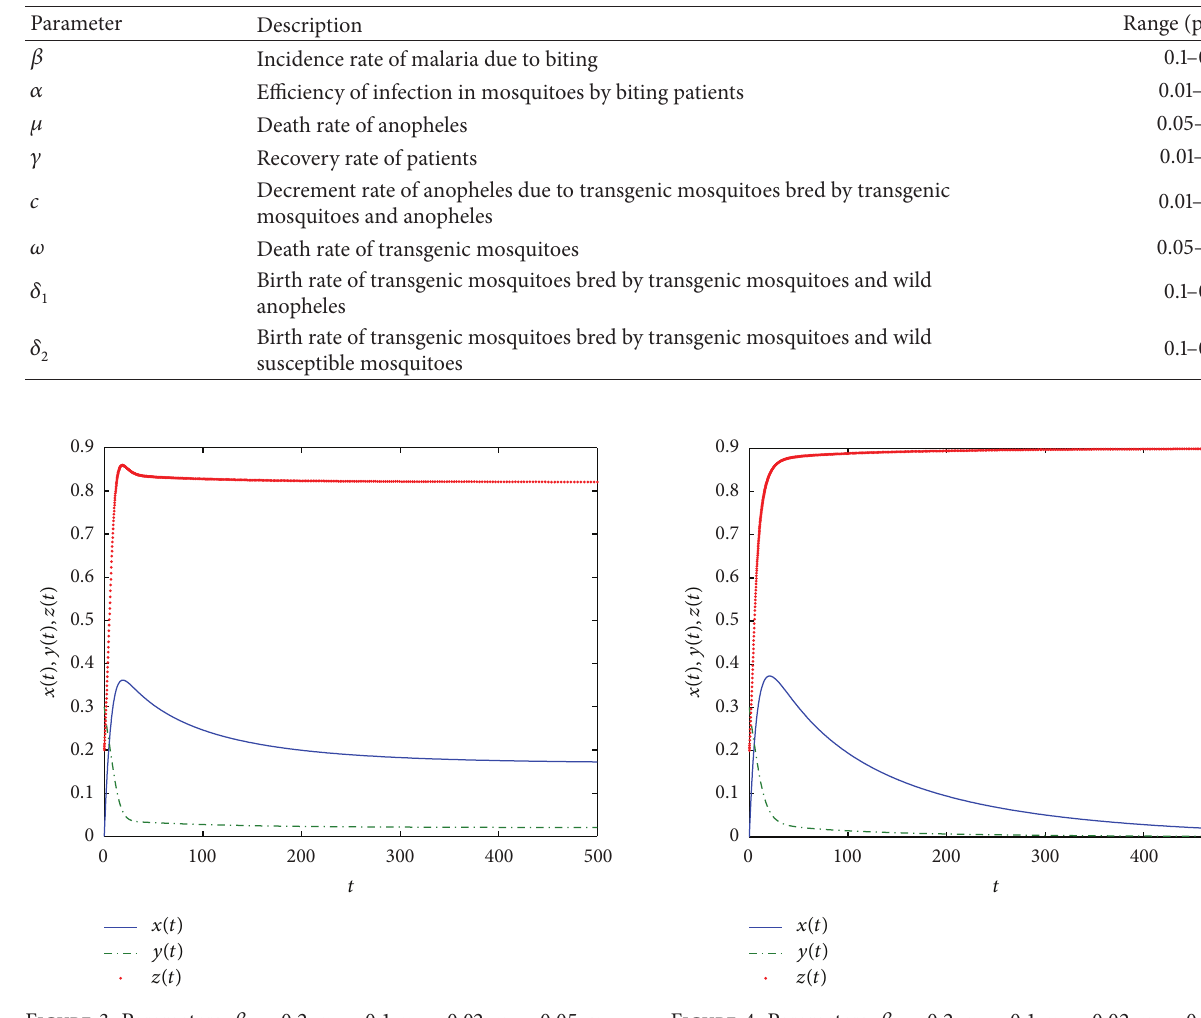
Figure 3: Parameters: 𝛽 = 0.2, 𝛼 = 0.1, 𝛾 = 0.02, 𝜇 = 0.05, 𝜔 = = 0.5, and 𝛿 = 0.25 . 0.05, 𝑐 = 0.1, 𝛿 1 2